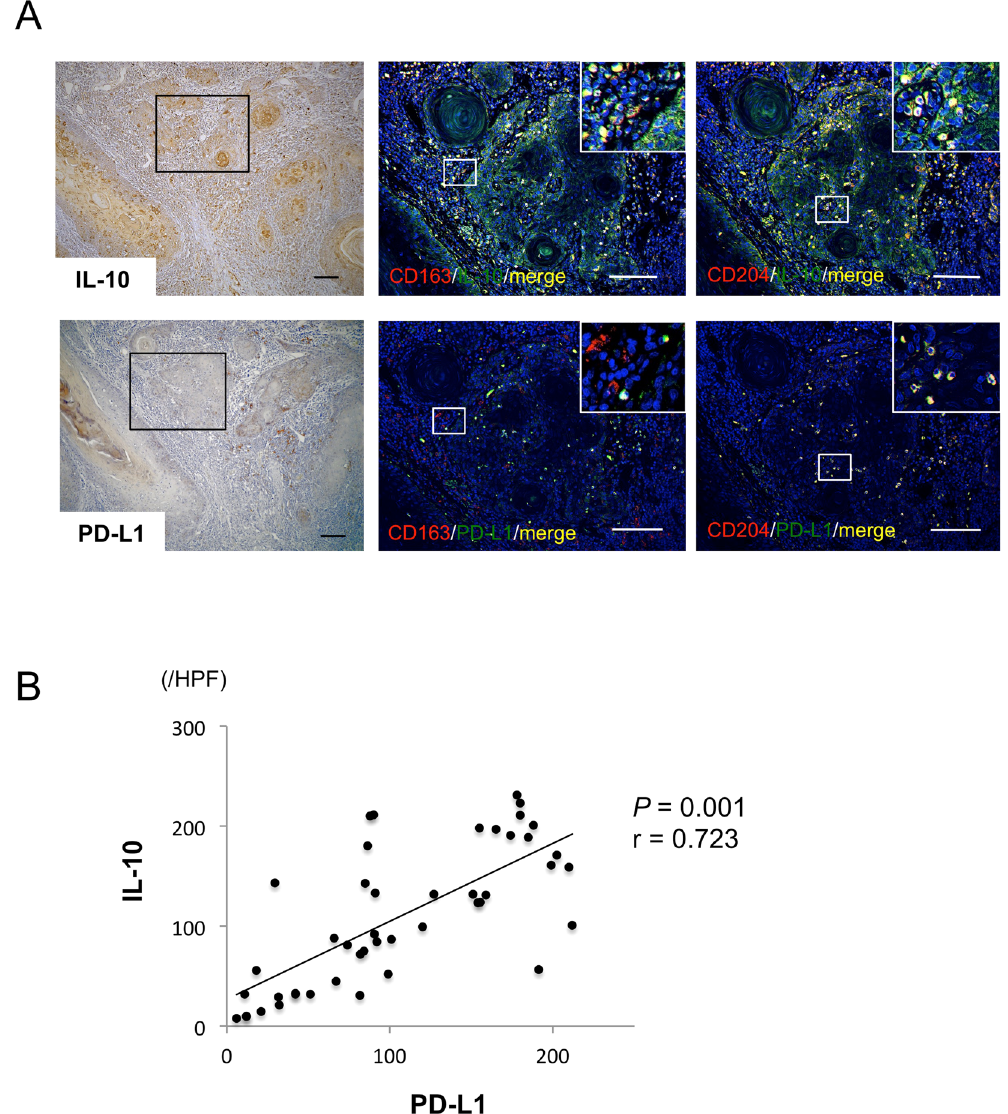
Figure 3. Co-localization of TAM markers and immunosuppressive molecules in OSCC. Representative images of paraffin sections in/around tumor stained with IL-10 (a) and PD-L1 (d). Counterstaining with Mayer’s hematoxylin is shown in blue. Double immunofluorescence staining performed with TAM markers (red) such as CD163 (b,e) and CD204 (c,f), and immunosuppressive molecules (green) such as IL-10 (b,c) and PD-L1 (e,f), and DAPI for staining nuclei (blue). (b,c,e,f) Merged CD163 and CD204 images (yellow). Scale bars, 50 μ